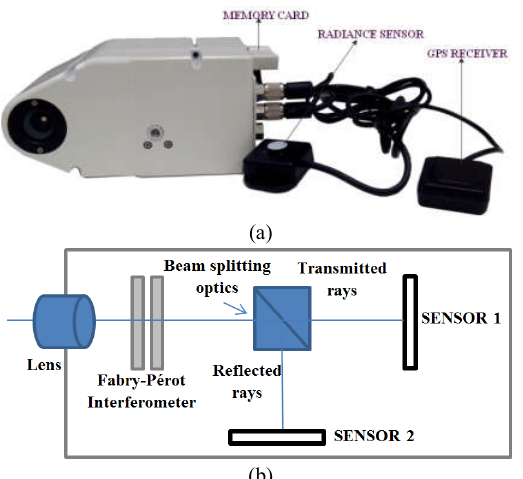
(b) Figure 1. (a) Rikola Hyperspectral camera with accessories and (b) diagram showing internal